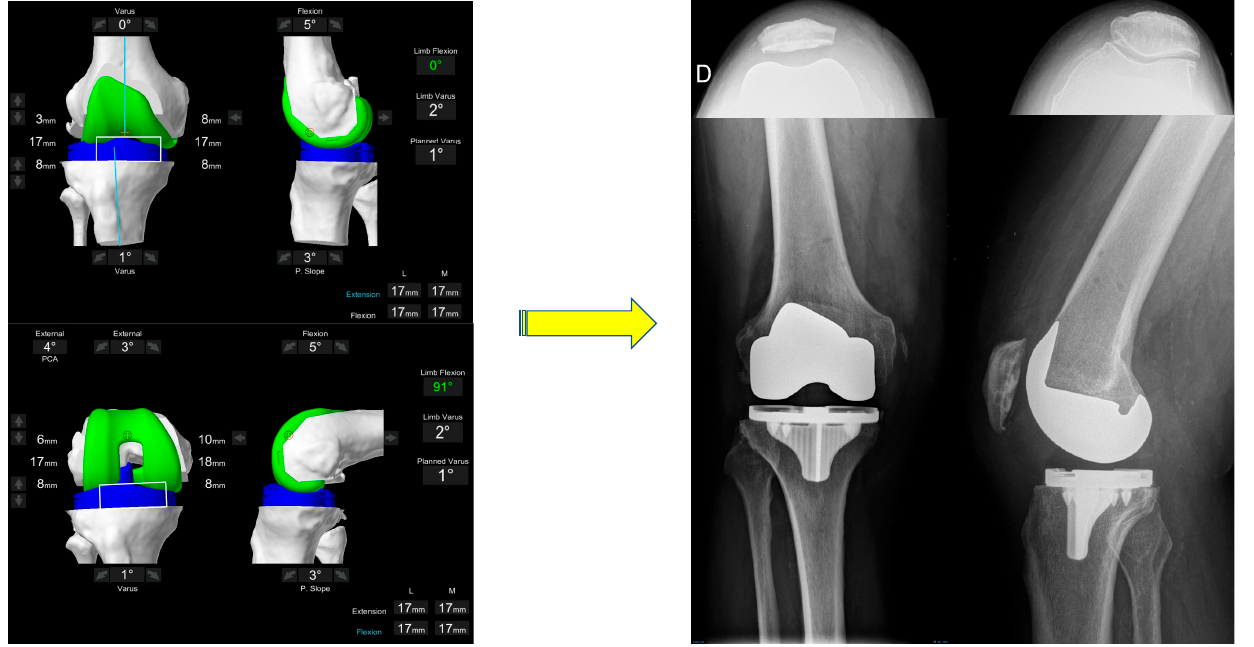
Figure 5. The final intra-operative position. Limb alignment, resections depth and tibiofemoral gaps in flexion and extension are shown. The achieved coronal alignment is 178°, or 2° varus and the sagittal alignment is 0° of flexion. The final gaps are 17 and 18mm, respectively. The post-operative X-ray at 3 months follow-up of the same patient is shown. The patella is well centred on the skyline X-ray.